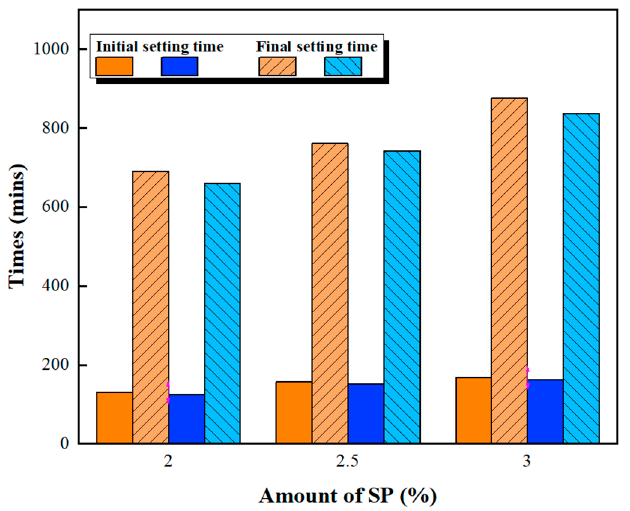
Figure 4. Setting time of green and ecofriendly grouting material with W/B = 0.27.